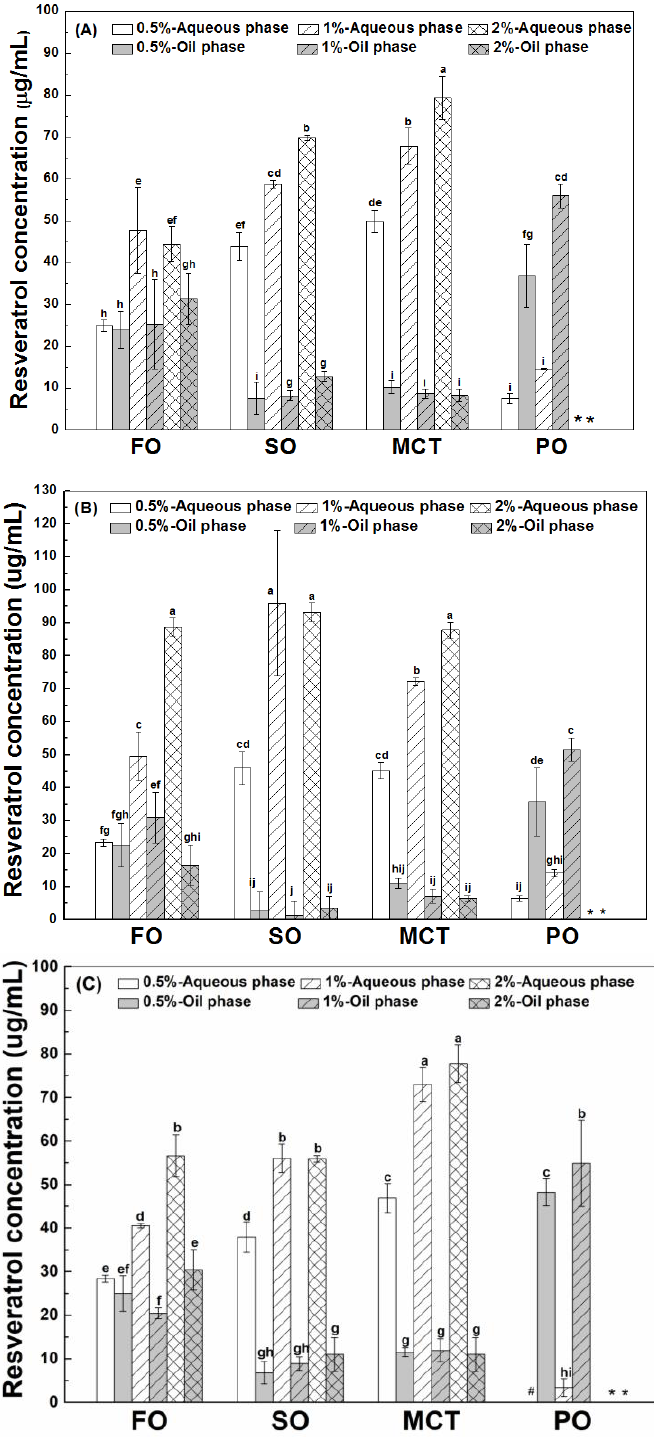
Figure 3. Final concentration of resveratrol in the aqueous and oil phase of emulsions stabilized by WPI ( A ), heat-denatured WPI ( B ) and sodium caseinate ( C ) at 0.5%, 1% and 2%. Different letters mean significant differences at p < 0.05. * Peppermint oil emulsions were unstable at 2% proteins. # Resveratrol was not detected.